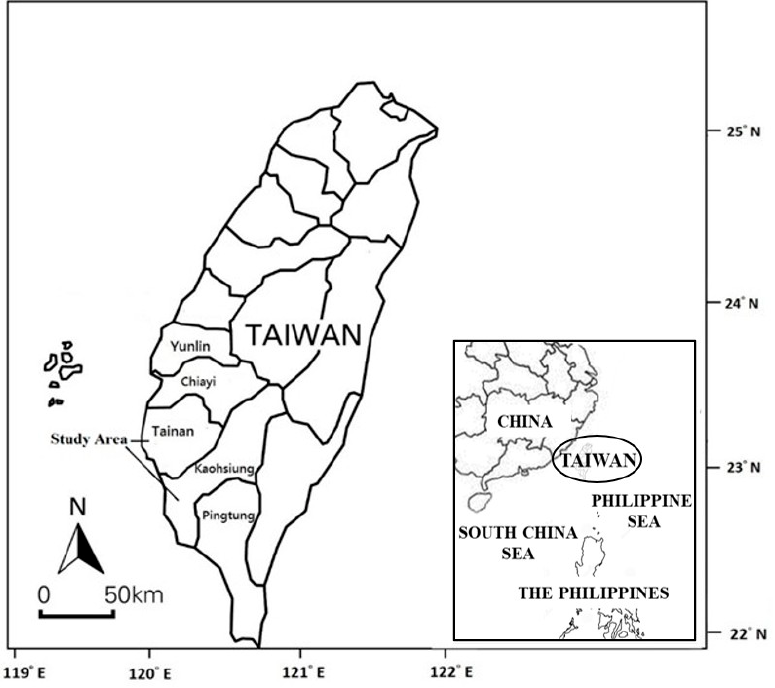
Figure 1. Geographical locations of the milkfish farms in Tainan County and Kaohsiung County, Taiwan .